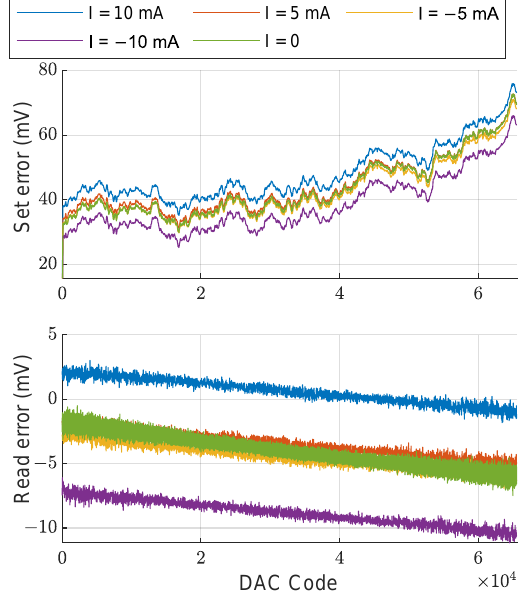
Figure 9. Characterization of set error ( top ) and read error ( bottom ) of current emulator board with different output current